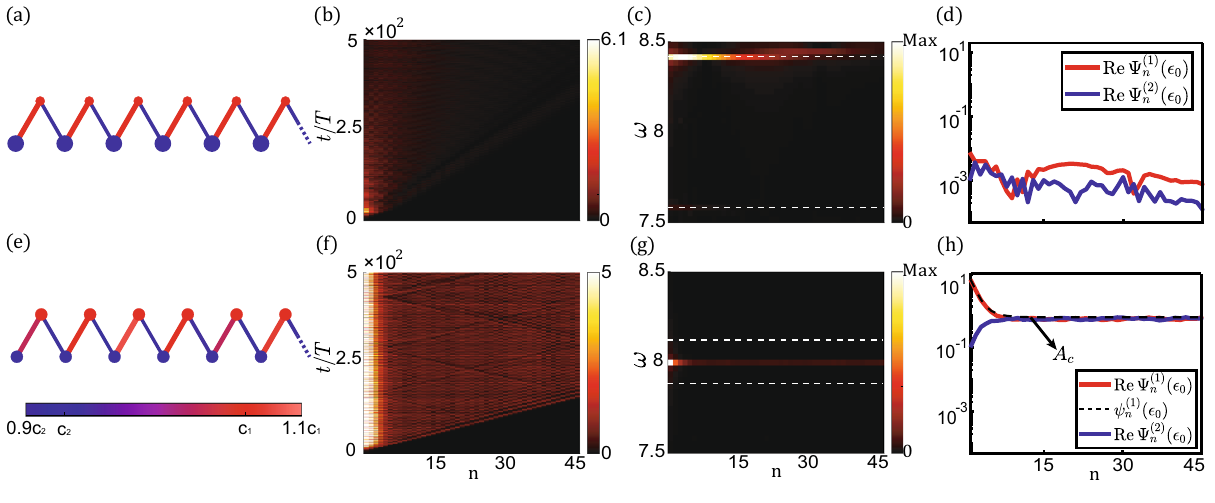
Fig. 4 Nonlinear boundary responses of the lattices in which re fl ection symmetry is broken in (a,b,c,d), and disorders are introduced in (e, f, g, h). ϵ 0 , c d c d 1 , 1 , 2 , 2 are carried over from Fig. 3, and the external Gaussian signal is adopted from Fig. 3(e). ( a ) and ( e ), the lattices are composed of cells with OBCs on both ends. Re fl ection symmetry is broken in ( a ) by letting ϵ A = (1 + 5%) ϵ 0 and ϵ B = (1 – 5%) ϵ 0 , which are represented by big blue and small red dots, respectively. Disorders are introduced in ( e ) by random parameters c i + δ c i,n and d i + δ d i,n . Here, the linear random couplings are depicted both by color and line width of the bonds. ( b ) and ( f ), spatial-temporal pro fi les of j R e Ψ ð 1 Þ n ð t Þj for 45 sites. ( c ) and ( g ), Fourier analysis is performed from 250 T to 500 T to have the spatial-frequency pro fi les of ( b ) and ( f ). ( d ) and ( h ), the spatial pro fi les of the ω = ϵ 0 component are represented by red and blue curves. Black dashed curve in ( h ) is the analytic result of the anomalous topological mode ψ ð 1 Þ n ð ϵ 0 Þ